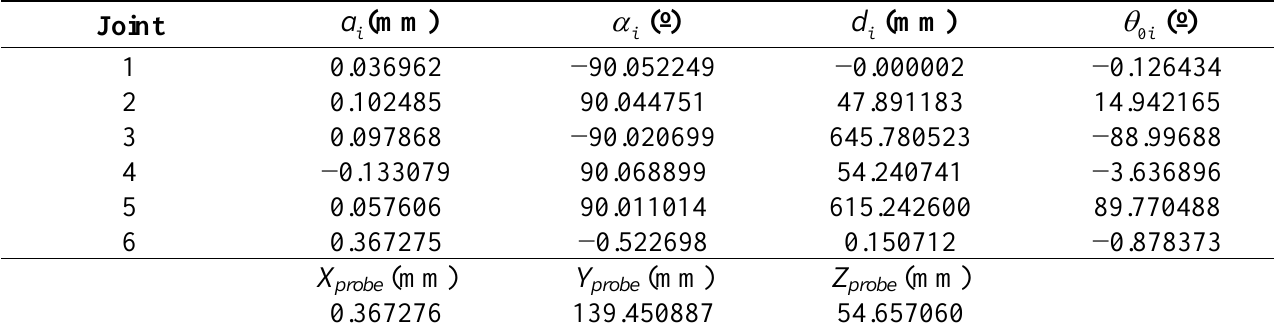
Table 1. Identified values for the model parameters by L-M algorithm [14].